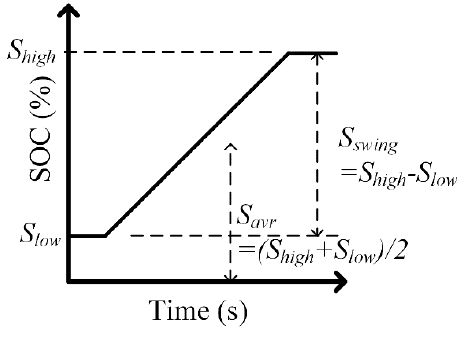
Figure 3. Concepts of S avr and S swing for calculating the lifecycle of the lithium (Li) battery.